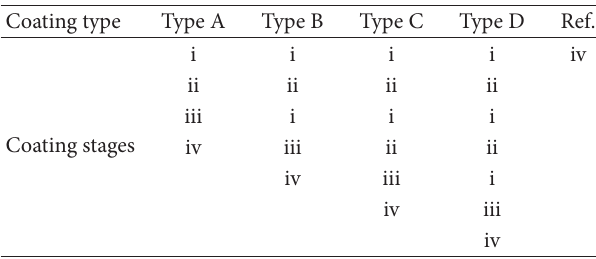
Figure 1: Fluidized bed apparatus. Table 1: Coating procedure (stages i, ii, iii, and iv described in Section